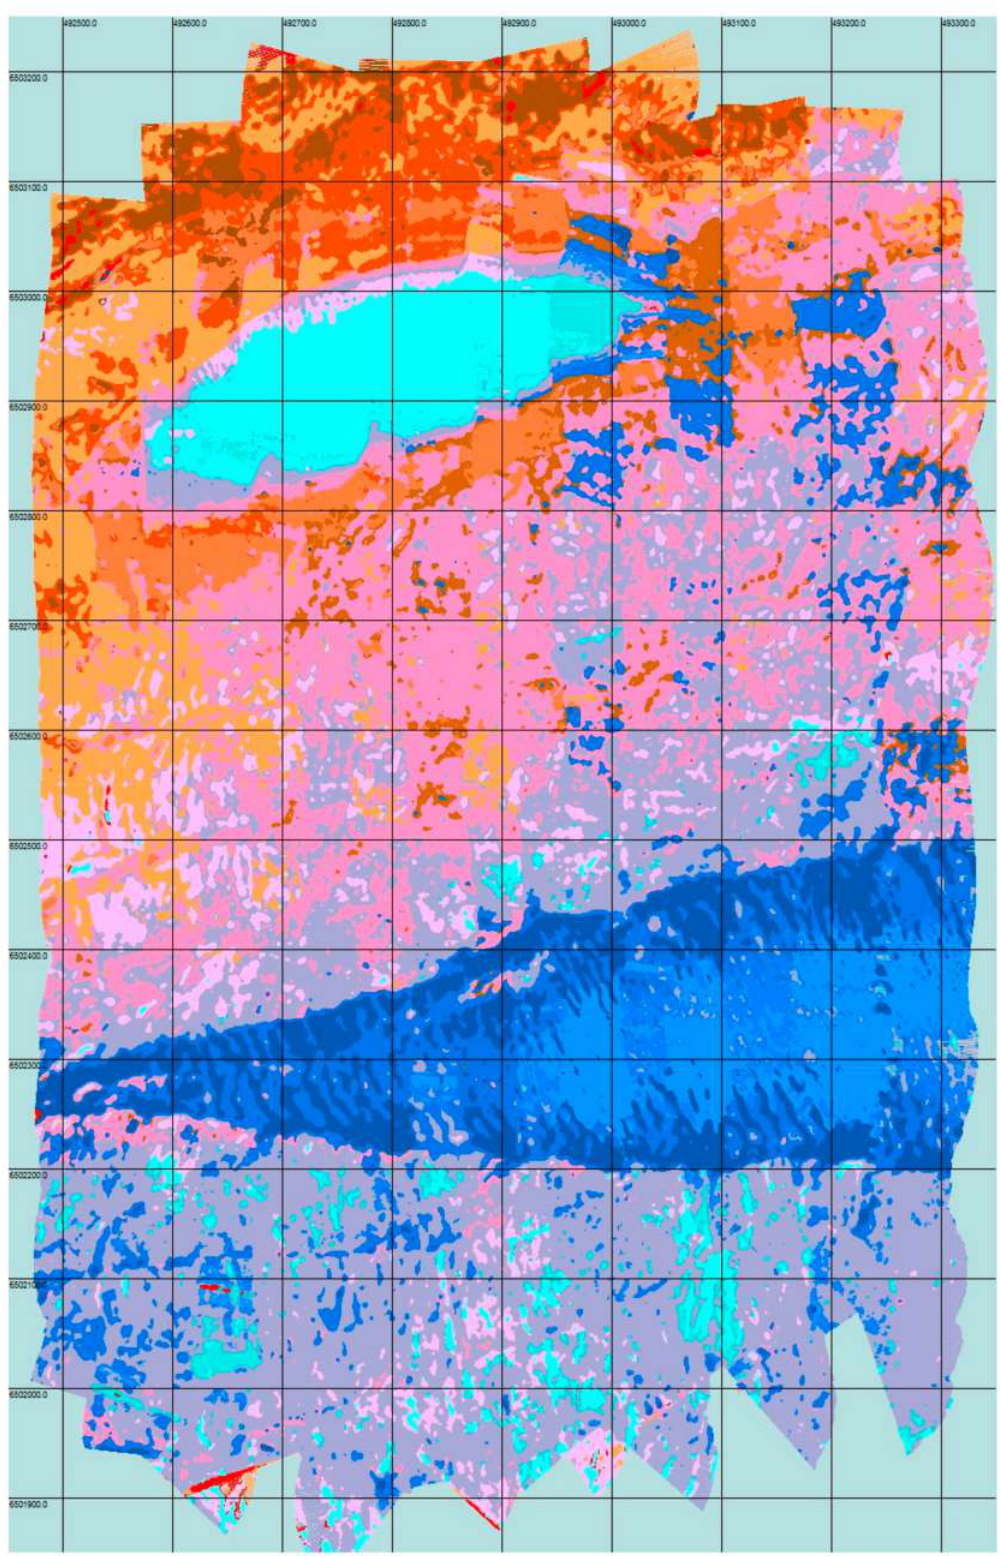
Figure 3. Inner Sound, Pentland Firth. A user-supervised texture-mapped image of the three-frequency colour sonar image shown in Figure 2 generated using (Kongsberg) GeoTexture software. Grid lines are at 100 metre intervals. The legend for the figure is given in Table